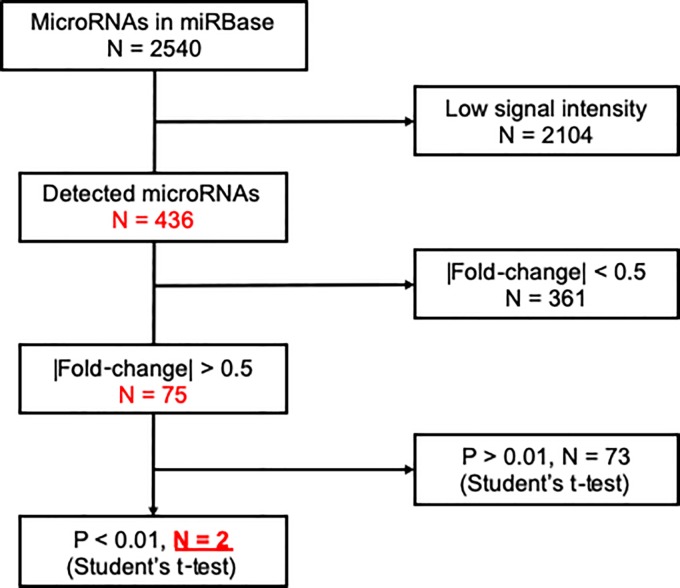
Flow diagram for detection of microRNAs.